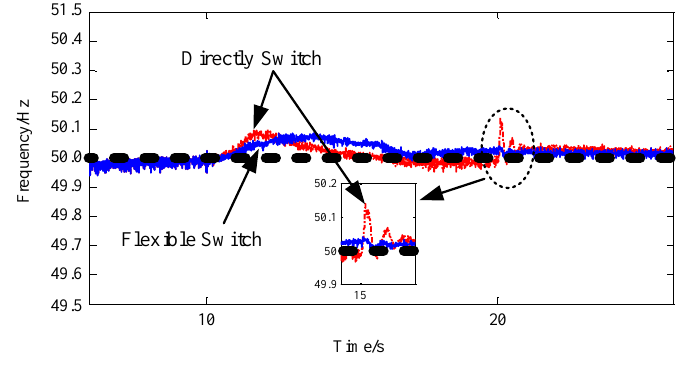
Figure 10. Effect of the flexible switch method.